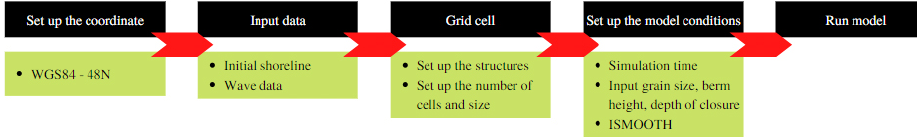
Figure 9. Main steps for running the GenCade model.